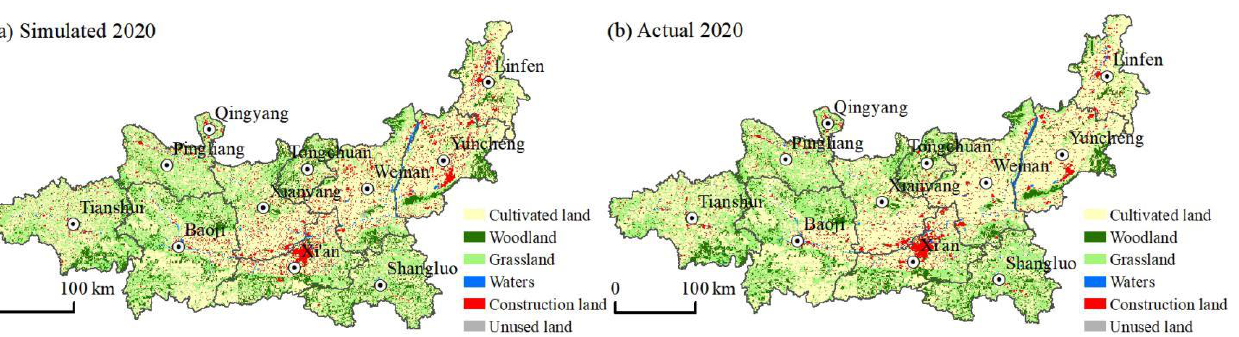
Figure A2. Land-use maps of the Guanzhong Plain urban agglomeration in ( a ) simulated 2020 and ( b ) actual 2020.